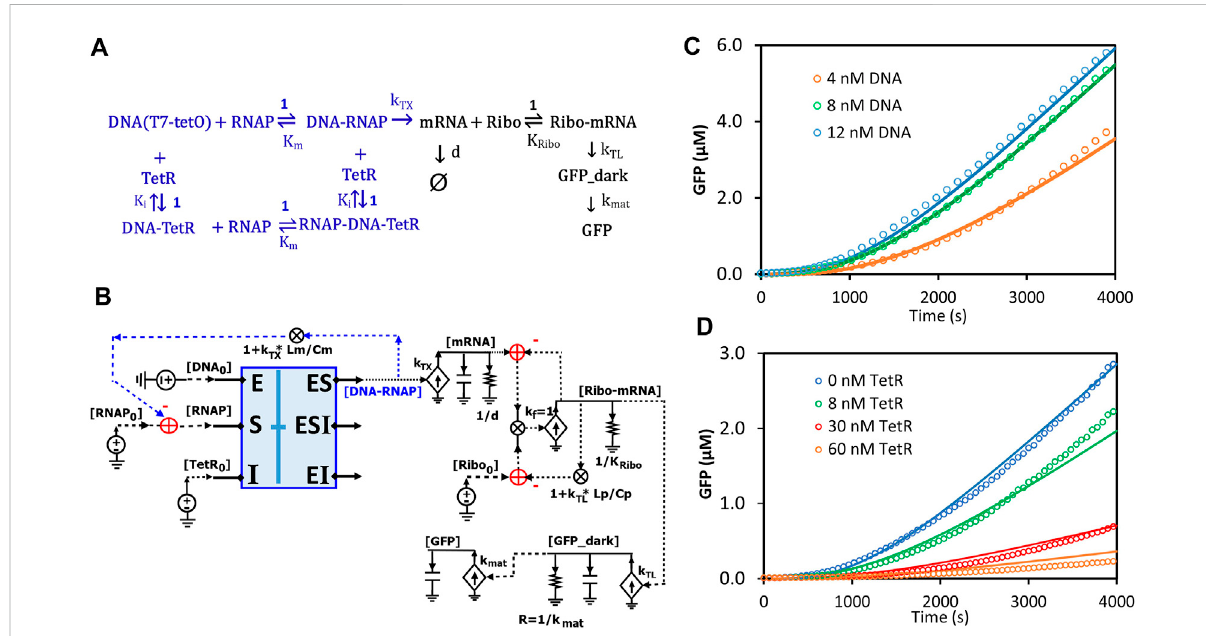
FIGURE 12 Circuit modeling of cell-free transcription and translation regulated by TetR. (A) The scheme for molecular binding and associated reactions of TXTL in the cell-free system with repression by TetR. The TXTL is turned on by a hybrid T7 promoter (DNA) and T7 RNA polymerase (RNAP) and repressed by TetR via non-competitive inhibition. The free RNAP-DNA complexes turn on transcription followedby the translationof GFP. The TetR used in the model is its homodimer. K i represents the dissociation constant (K d ) of the homodimer binding to the DNA (tetO). (B) The circuit model exactly describes thekinetics of molecular binding and associated reactions in (A) . Inthe non-competitive bindingblock(blue box), DNA acts in a manner like an enzyme where both the substrate (RNAP) and the inhibitor (TetR) bind to it. Only free [DNA-RNAP] turns on transcription. (C) Model curves of GFP dynamics fi tted to experimental data points with varying DNA concentrations when TetR = 0 nM. (D) Model curves of GFP dynamics fi tted to experimental data points with varying TetR concentrations at constant DNA concentration (6 nM). All data points are means of three independent replicates with standard deviations less than 20% of the corresponding mean (not